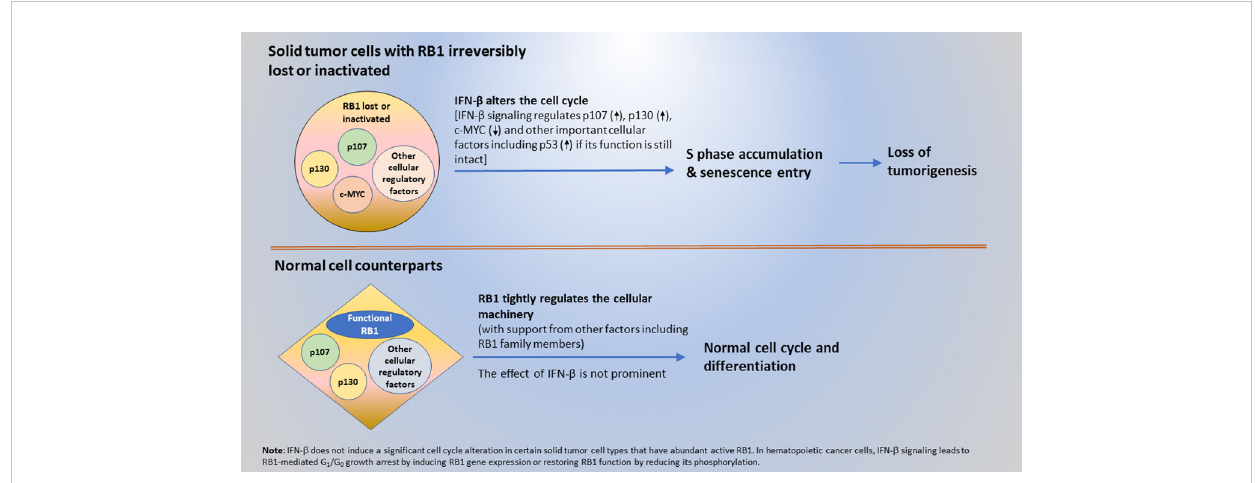
FIGURE 2 A mechanism of anti-cancer surveillance for selective suppression of tumor or transformed cells mediated by the interplay between tumor suppressor proteins IFN- b and